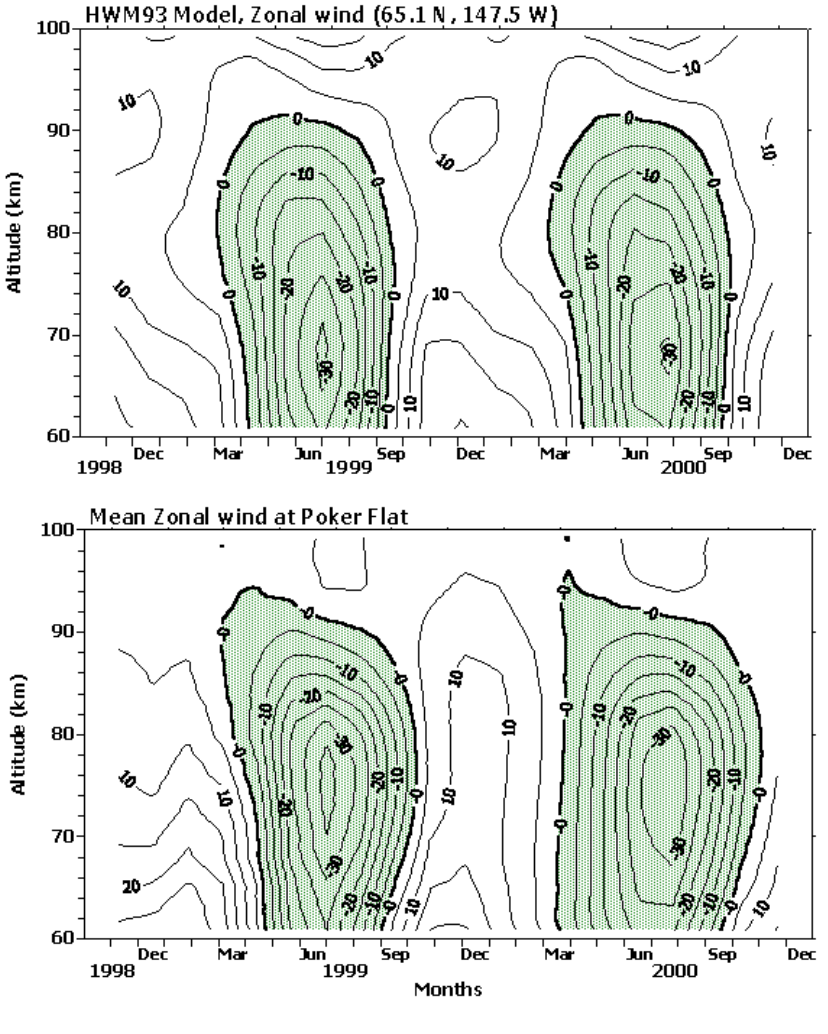
Fig. 2. Time-height cross section of the mean zonal wind component (bot- tom) observed at Poker Flat from Octo- ber 1998 to December 2000. HWM93 (Hedin et al., 1996) model contours for Poker Flat are given in the top panel. Shaded regions represent the regimes of westward